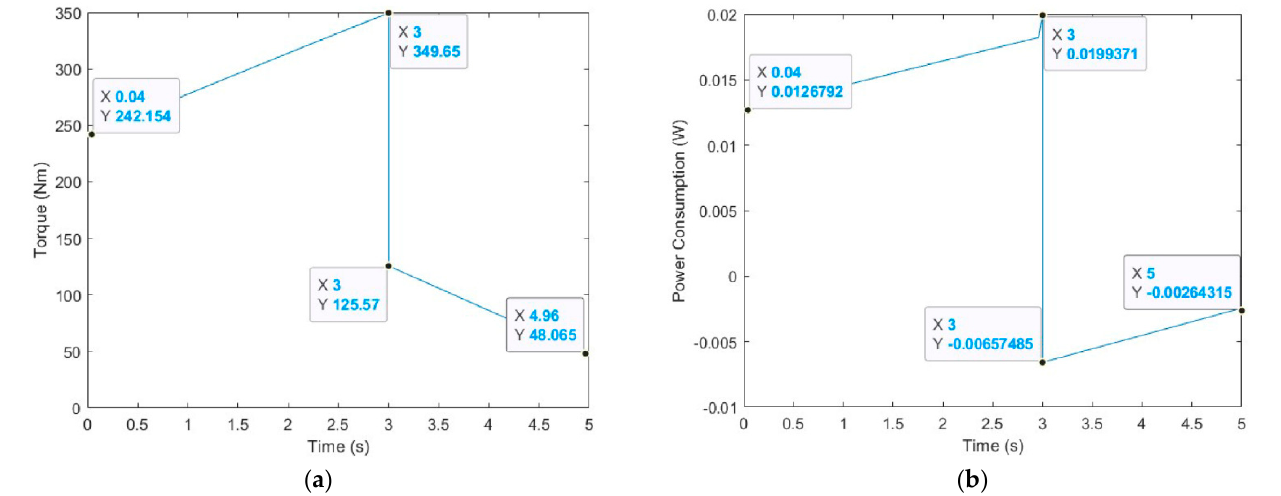
Figure 11. Multibody simulations: ( a ) torque, ( b ) power consumption.